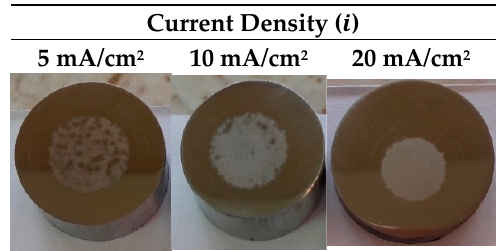
Figure 3. ( a ) SEM image of the anodic layer grown in a glycerol, 0.3 M NaAlO 2 and 10 vol% H 2 O for 30 min at 20 mA/cm 2 . ( b ) Potentiodynamic polarization curves for anodic layers grown in glycerol electrolyte containing 0.3 M NaAlO 2 .